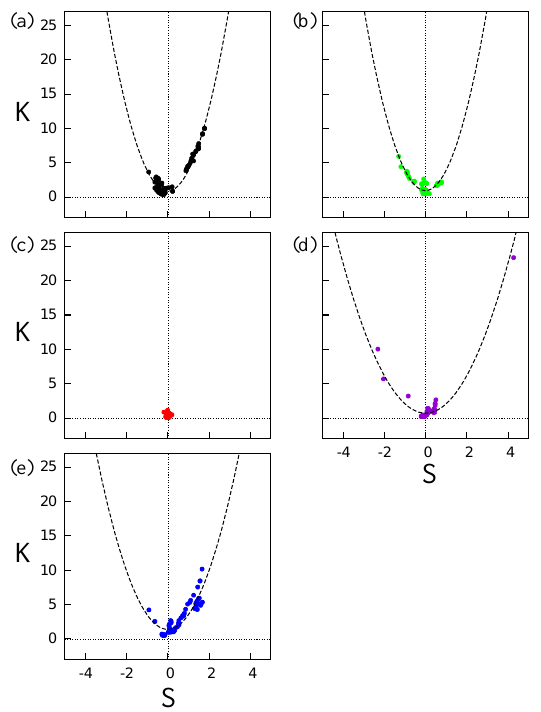
Figure 8. Kurtosis K as a function of skewness S computed from the time series of δ | B | (τ) , where τ = 10s. (a) The interior region of IMFR-1, (b) the interface of IMFR-1 and IMFR-2, (c) the interior of IMFR-2, (d) the interface of IMFR-2 and IMFR-3, and (e) the inte- rior of IMFR-3. In each panel, the least-square fit with the parabolic function K = αS 2 + β is displayed as a dashed line (see Table